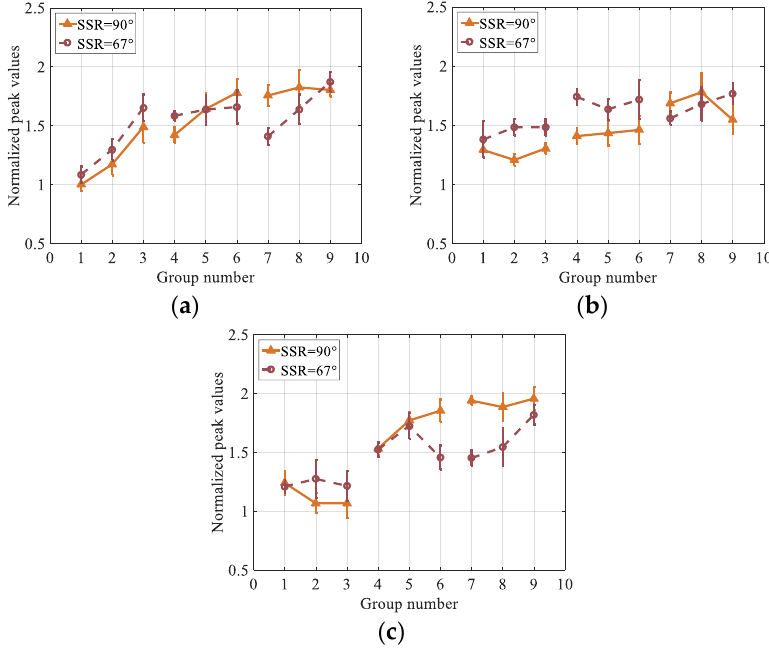
Figure 11. Milling forces comparison between two scan strategies: ( a ) Case 1 (milling in XY plane), ( b ) Case 2 (milling in XZ plane), ( c ) Case 3 (milling in YZ plane).